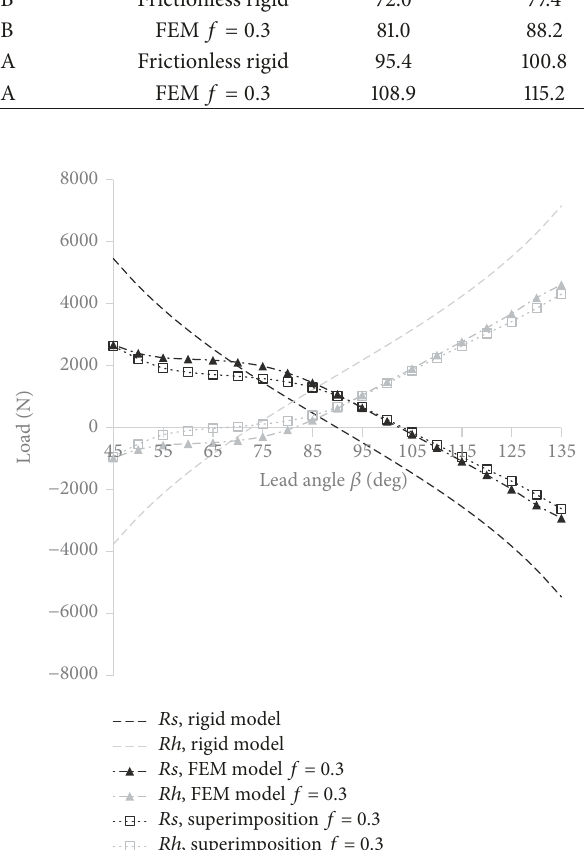
Figure 13: Reactions of shaft and hub constraints for different lead angles under combined load calculated by means of the frictionless rigid and the FEM model (friction factor = 0.3) as well as by summing results from analyses under force and torque loads.